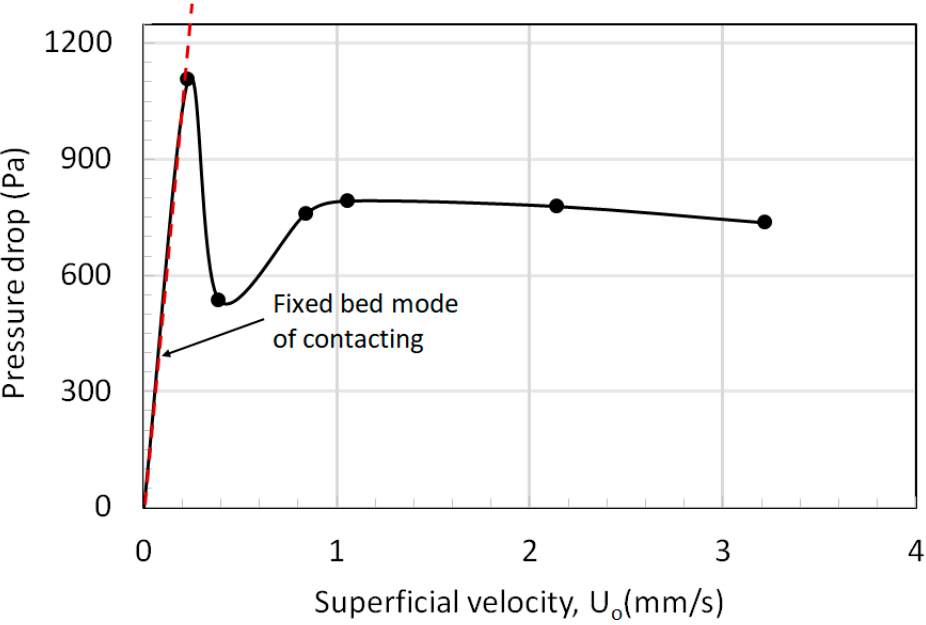
Figure 10. Fluidization behavior of the monocomponent bed of activated carbon at ambient conditions using nitrogen gas.